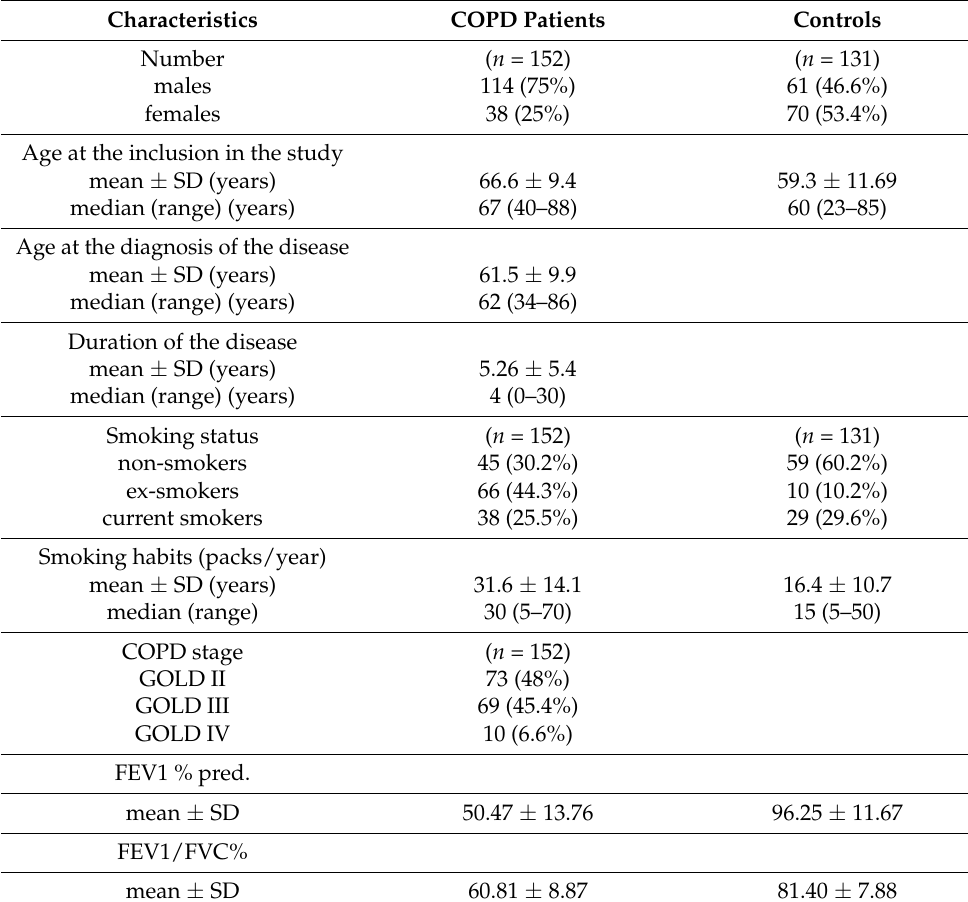
Table 1. Demographic and clinical data of COPD patients and controls. Characteristics COPD Patients